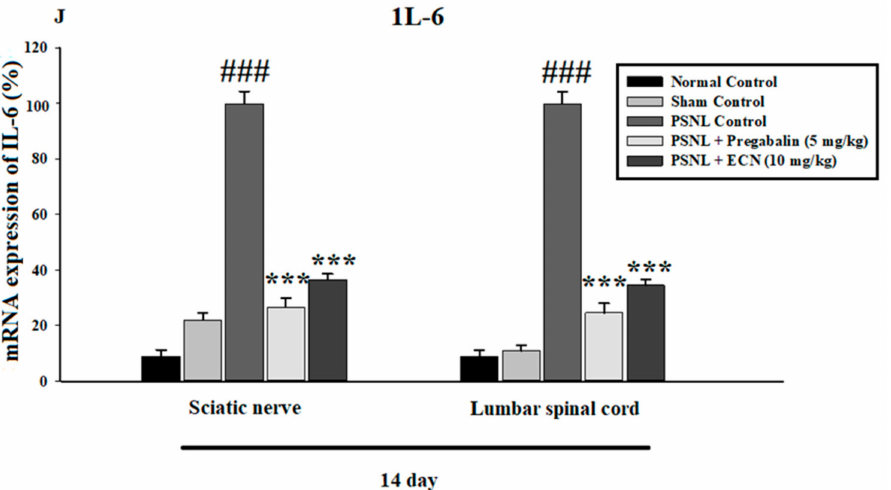
Figure 8. Effect of ECN (10 mg/kg) on the COX-2, iNOS, TNF α , IL-1 β and IL-6 expression in the spinal cord and sciatic nerve tissue using PCR. ( A ) ECN (10 mg/kg) significantly inhibited the COX-2 in the sciatic nerve and spinal cord tissue on day 7 post-PSNL surgery. ( B ) ECN (10 mg/kg) significantly inhibited the COX-2 in the sciatic nerve and spinal cord tissue on day 14 post-PSNL surgery. ( C ) ECN (10 mg/kg) significantly inhibited the iNOS in the sciatic nerve and spinal cord tissue on day 7 post-PSNL surgery. ( D ) ECN (10 mg/kg) significantly inhibited the iNOS in the sciatic nerve and spinal cord tissue on day 14 post-PSNL surgery. ( E ) ECN (10 mg/kg) significantly inhibited the TNF- α in the sciatic nerve and spinal cord tissue on day 7 post-PSNL surgery. ( F ) ECN (10 mg/kg) significantly inhibited the TNF- α in sciatic nerve and spinal cord tissue on day 14 post-PSNL surgery. ( G ) ECN (10 mg/kg) significantly inhibited the IL-1 β in the sciatic nerve and spinal cord tissue on day 7 post-PSNL surgery. ( H ) ECN (10 mg/kg) significantly inhibited the IL-1 β in the sciatic nerve and spinal cord tissue on day 14 post-PSNL surgery. ( I ) ECN (10 mg/kg) significantly inhibited the IL-6 in sciatic nerve and spinal cord tissue on day 7 post-PSNL surgery. ( J ) ECN (10 mg/kg) significantly inhibited the IL-6 in sciatic nerve and spinal cord tissue on day 14 post-PSNL surgery. The data is presented as the mean (n = 3) ± S.D. Different letters meant statistically significant differences: (***) p < 0.001 indicate significant differences from the PSNL control group. (###) indicate significant differences from the normal control group. *** p < 0.001 (two-way ANOVA followed by Dunnett’s